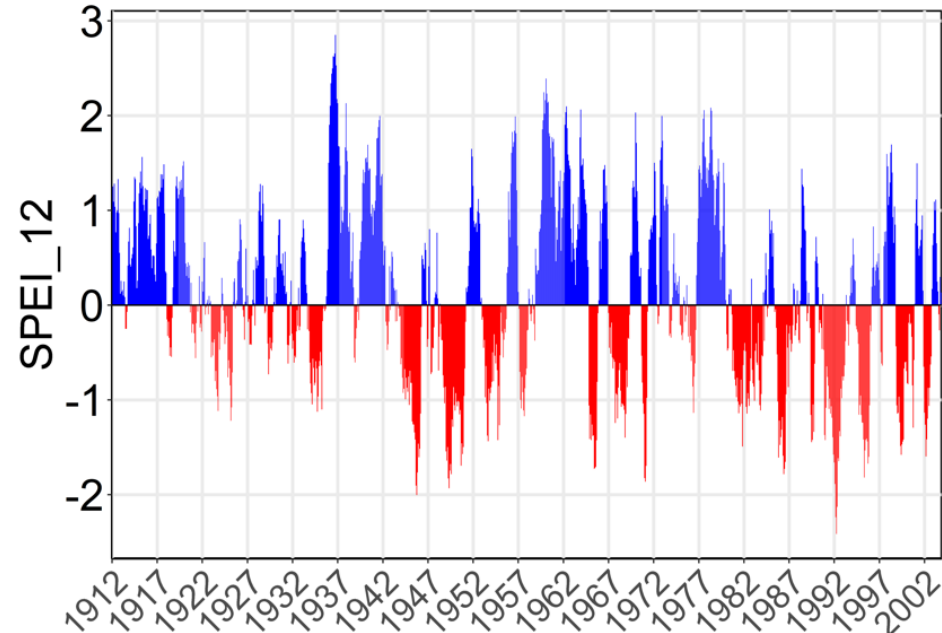
Figure 5. 12-month Standardized Precipitation Evapotranspiration Index (SPEI_12) for the study area from 1902 to 2018.